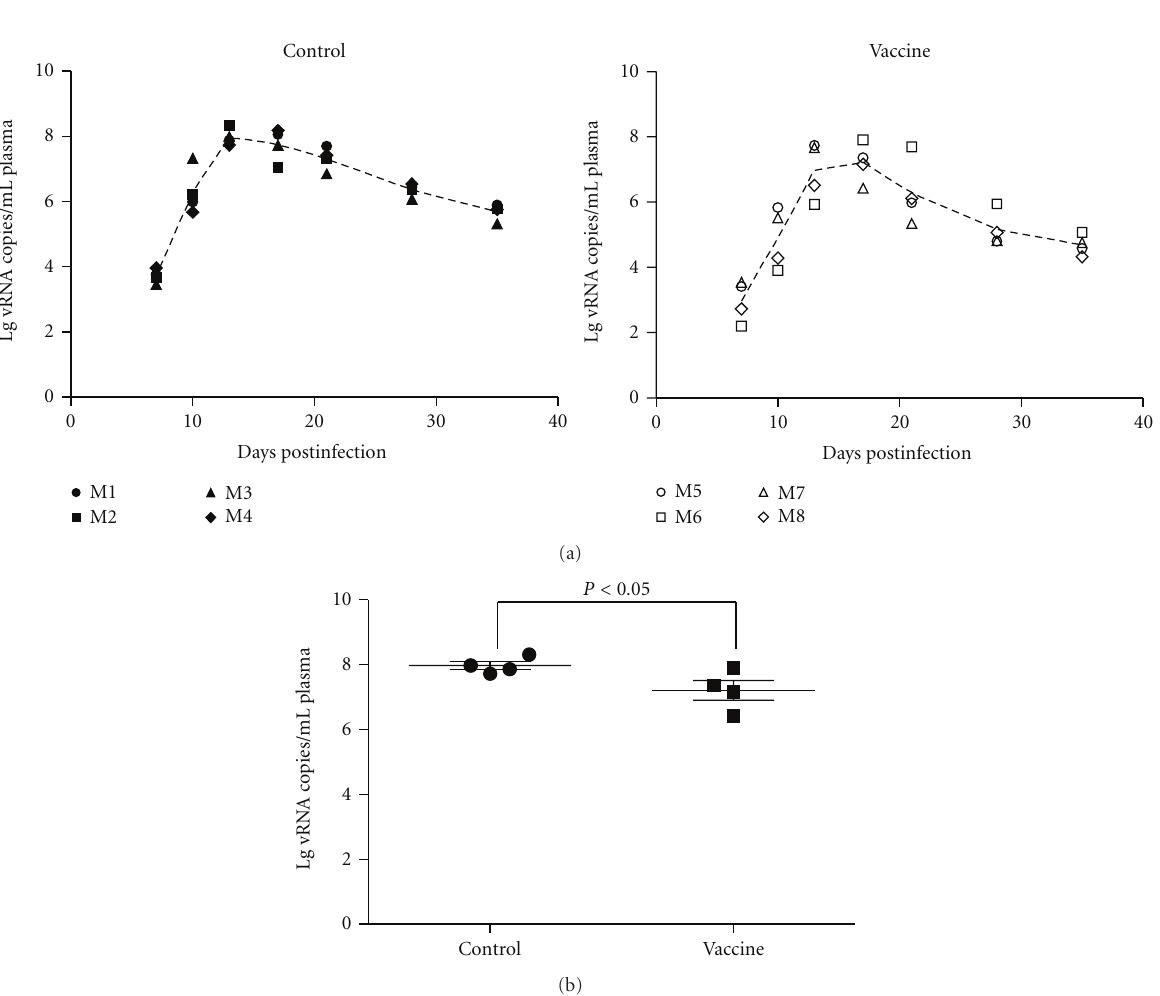
Figure 4: Plasma viral load analysis post-SHIV-KB9 challenge. Viremia was quantified by RT-PCR. (a) Dynamics of viral load for each group. (b) Average value of viral load for each